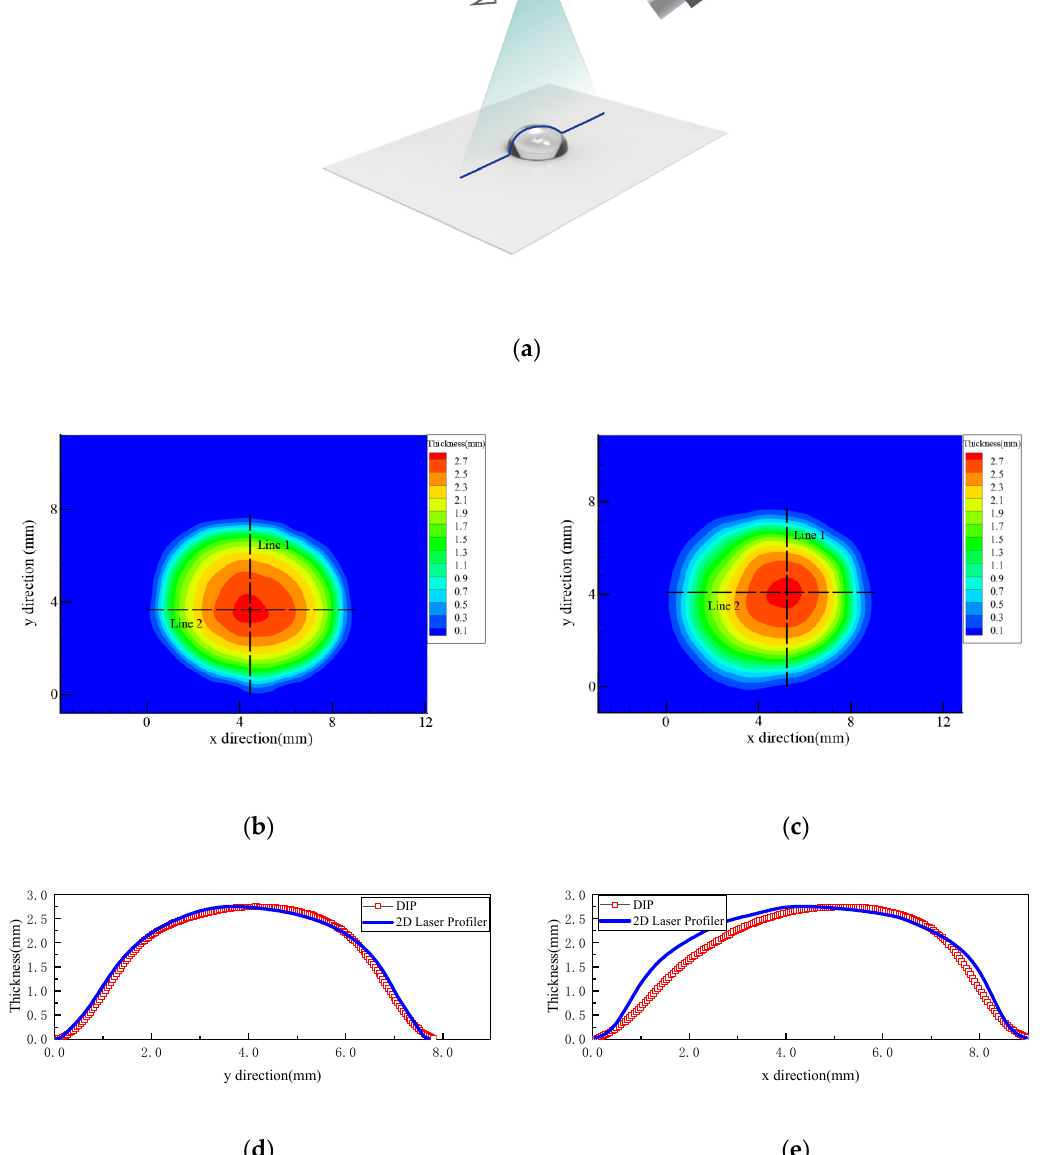
Figure 10. Measuring results of a droplet on the flat plane: ( a ) droplet on a flat surface; ( b ) result of 2D laser profiler; ( c ) result of DIP; ( d ) thickness along Line 1; ( e ) thickness along Line 2.